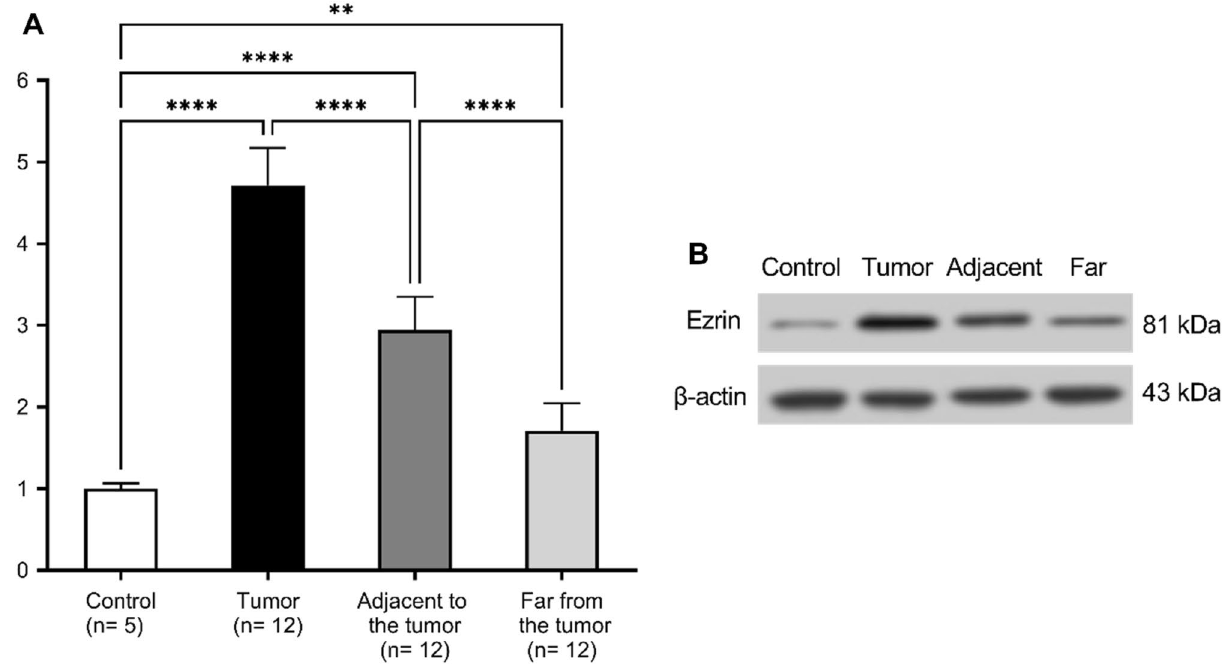
Figure 7. ( A ) Relative expression levels of ezrin protein. ( B ) Western blot images for ezrin expression. Results are expressed as mean ± SD, **** p < 0.001, ** p <